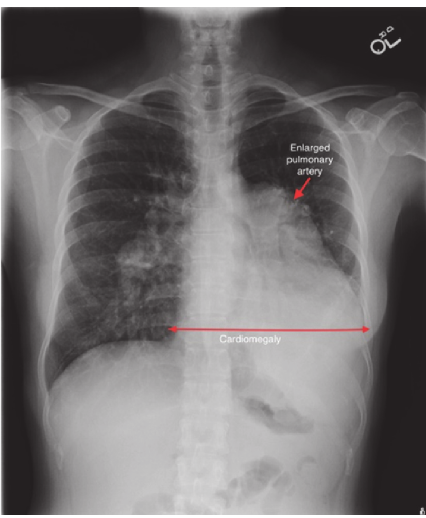
Figure 1: A chest radiograph shows a markedly enlarged pulmonary trunk(redarrow),enlargedcentralpulmonaryarteries,andenlarge- ment of the cardiac